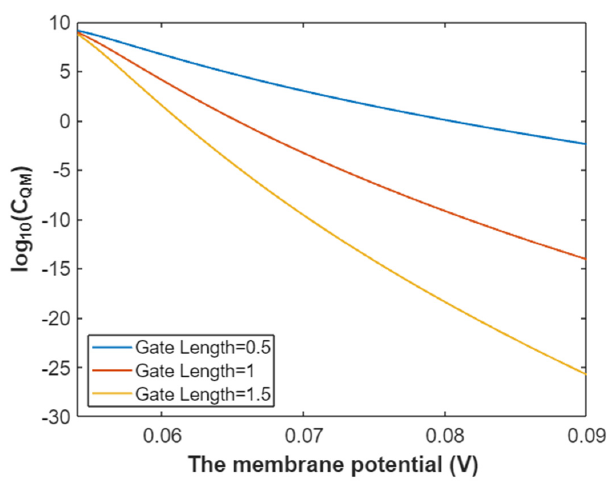
Figure 13. The relationship between membrane potential and the common logarithm of quantum membrane conductance of extracellular sodium ions at G = 6.33 J and over a membrane potential range from 0.054 V to 0.09 V.